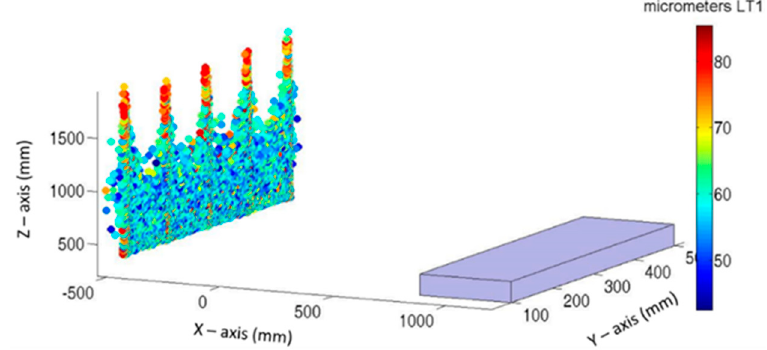
Figure 10. Best LT position and maximum error obtained on each Monte Carlo test: X-axis direction.